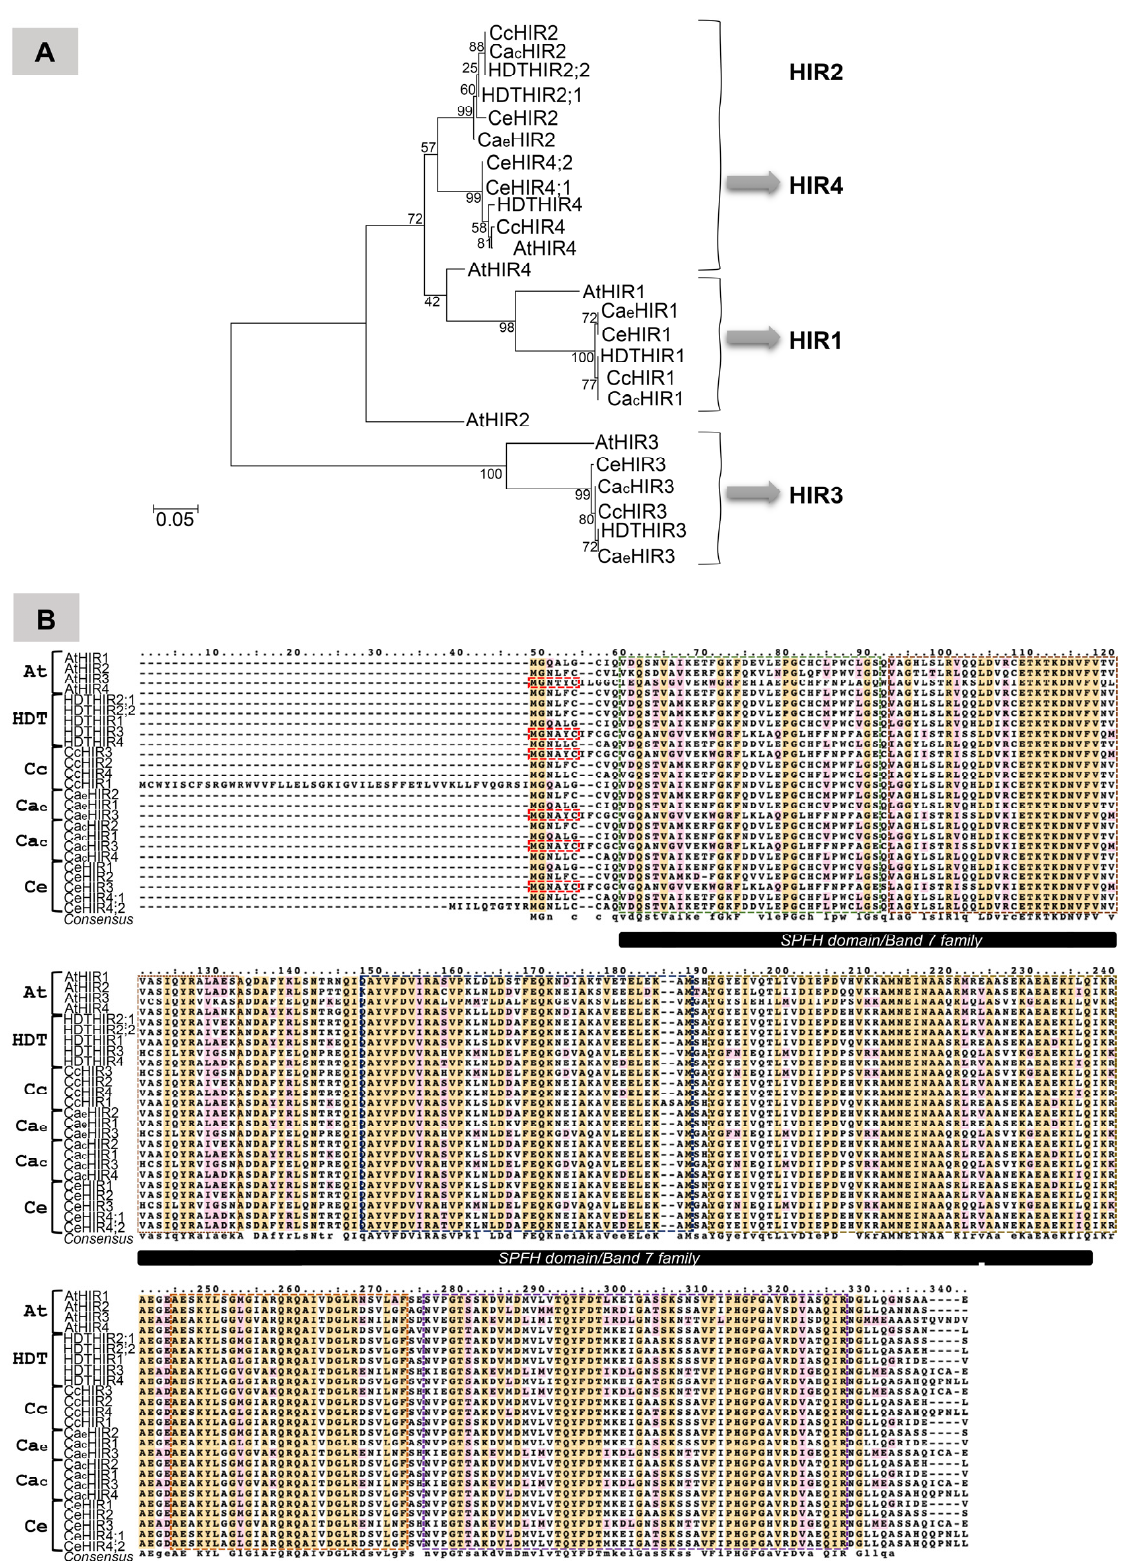
Figure 6. ( A ) Phylogenetic tree of putative HIR proteins from Arabidopsis thaliana (At), Coffea arabica (Ca), C. canephora (Cc), C. eugenioides (Ce) and Coffea Timor hybrid (HDT). The tree was drawn to scale and constructed using the maximum likelihood method conducted in software MEGA7. ( B ). Amino acid sequence alignment of HIR proteins from Arabidopsis thaliana (At), Coffea arabica (Ca), Co ff ea canephora (Cc), Co ff ea eugenioides (Ce) and Co ff ea HDT. The multiple sequence alignment was